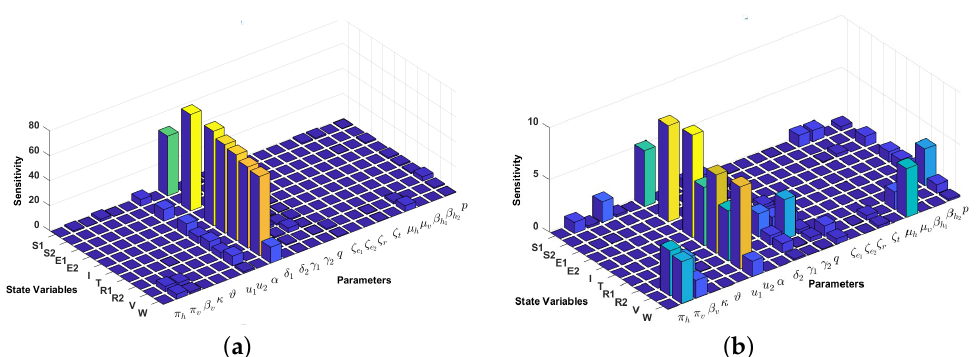
Figure 7. Local sensitivity analysis with full–normalization technique of all variables with respect to all parameters ( a ) and without δ 1 ( b ). We use incidence data from West-Papua and the following initial conditions: S 1 ( 0 ) = 918,167, S 2 ( 0 ) = 0, E 1 ( 0 ) = 399, E 2 ( 0 ) = 0, I ( 0 ) = 242, T ( 0 ) = 51, R 1 ( 0 ) = 22, R 2 ( 0 ) = 88, V ( 0 ) = 1,915,967, W ( 0 ) = 641 to run the